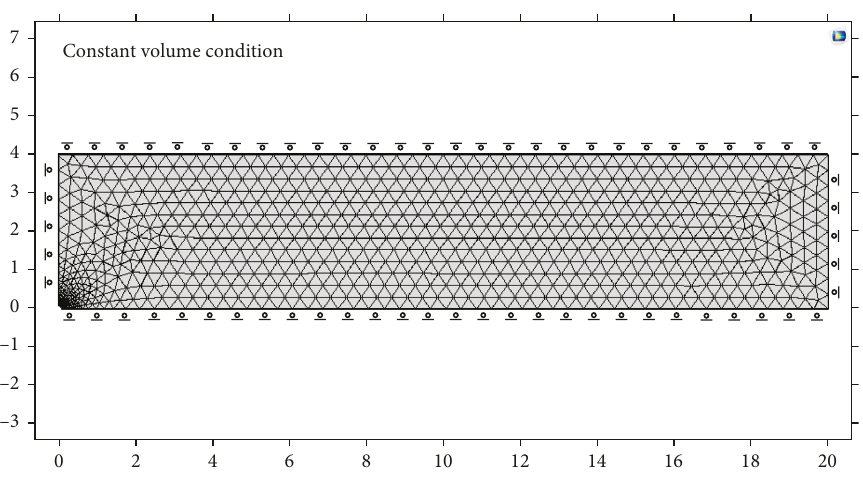
Figure 13: Illustration of the numerical model under constant volume